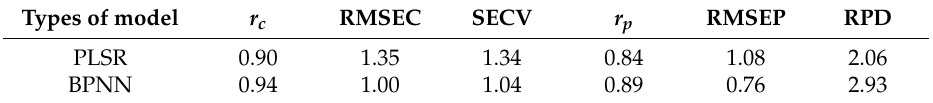
Table 4. Comparison of the calibration model results with PLSR and BPNN.